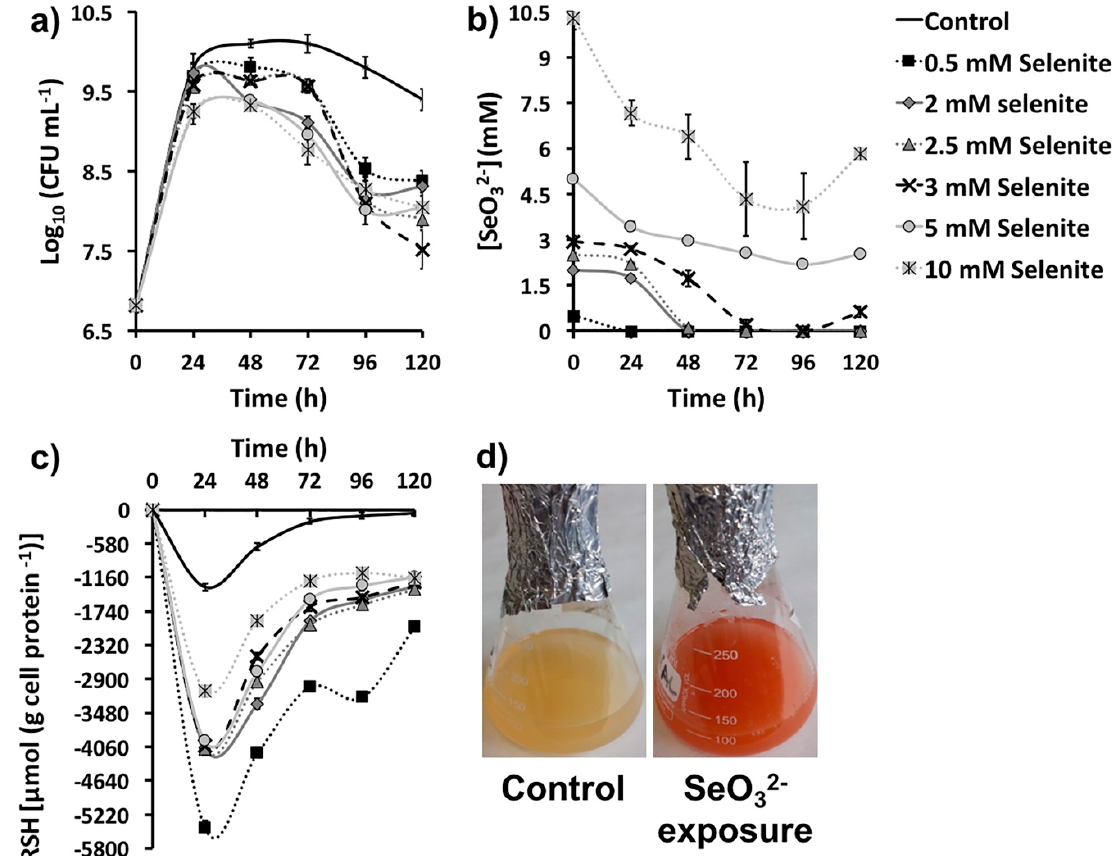
Figure 1. ( a ) Growth profiles, ( b ) SeO 32 − bioconversion, and ( c ) thiol (RSH) oxidation of MPV1 cultures grown in LB medium, or LB supplied with increasing concentrations (0.5, 2, 2.5, 3, 5, and 10 mM) of